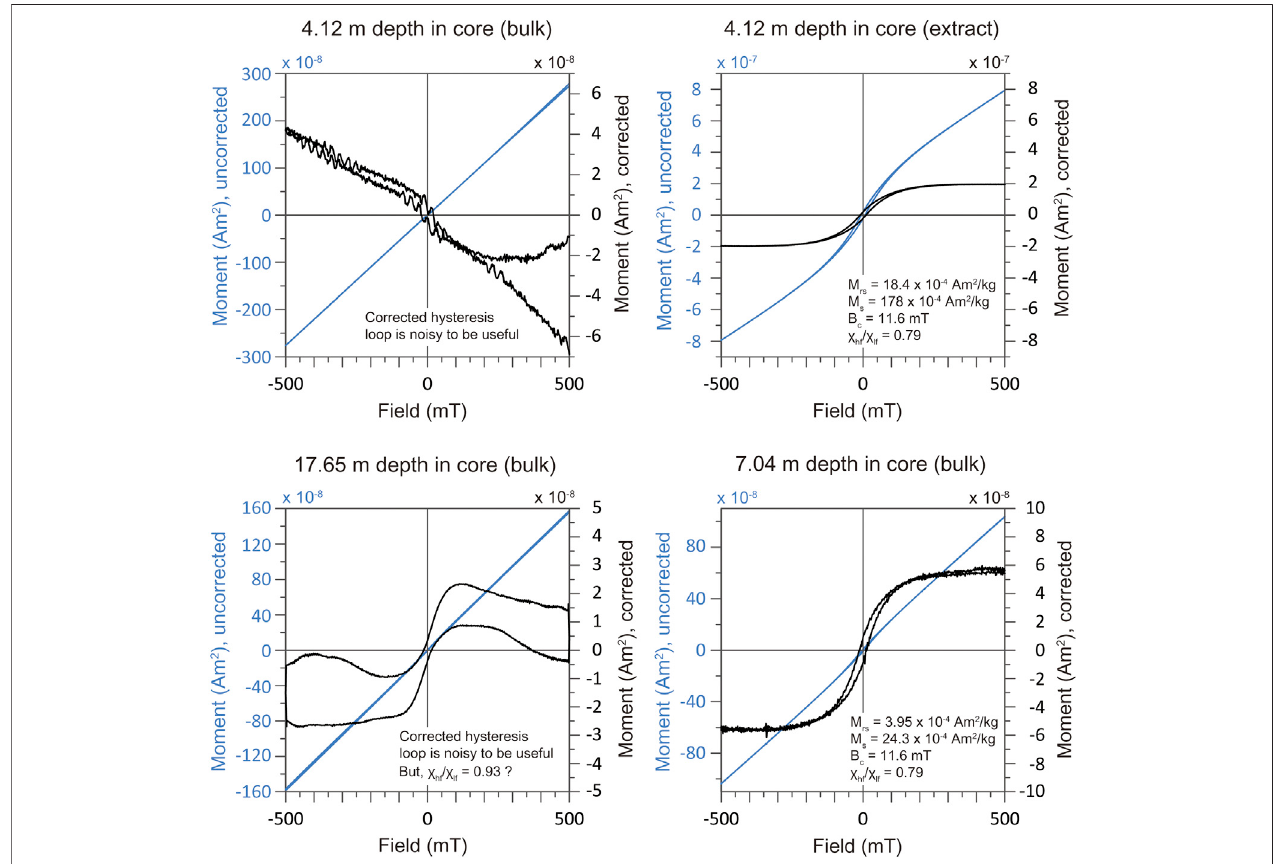
FIGURE 5 | Examples of measured (uncorrected) and high- fi eld slope (i.e., paramagnetic contribution) corrected hysteresis loops. The differences between uncorrected and corrected loops indicate substantial non-ferromagnetic (i.e., paramagnetic) contribution in the studied sediments. Note that, for the extract subsample of 17.65 m depth (in core), the corrected loop seems to be less well-constrained so that the hysteresis parameters (M rs , M s , and B c ) could not be determinable, but the determined χ hf / χ lf seems